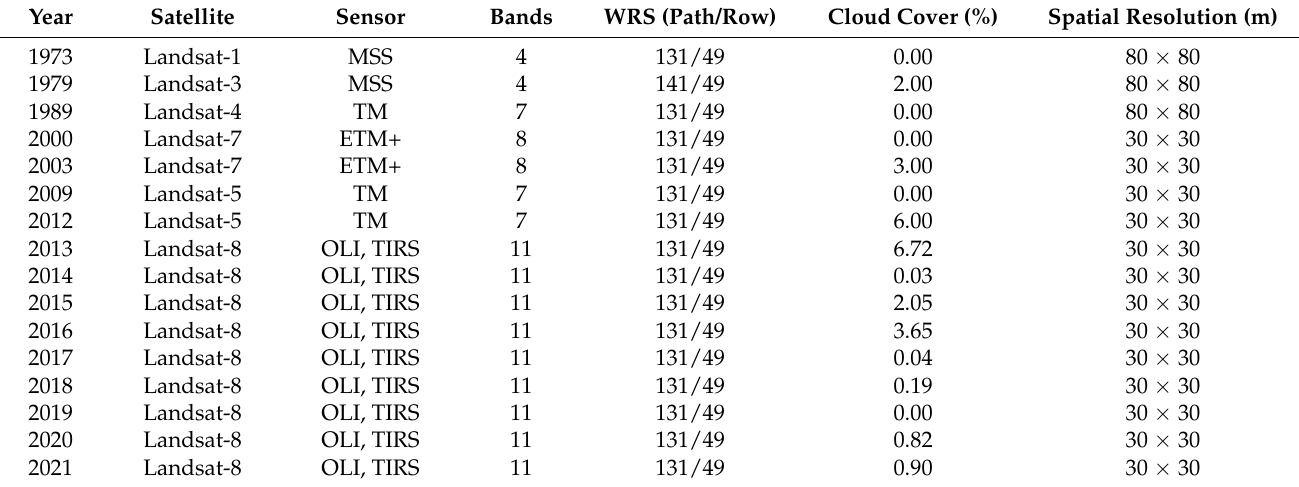
Table 1. Information table of clear-sky remote sensing